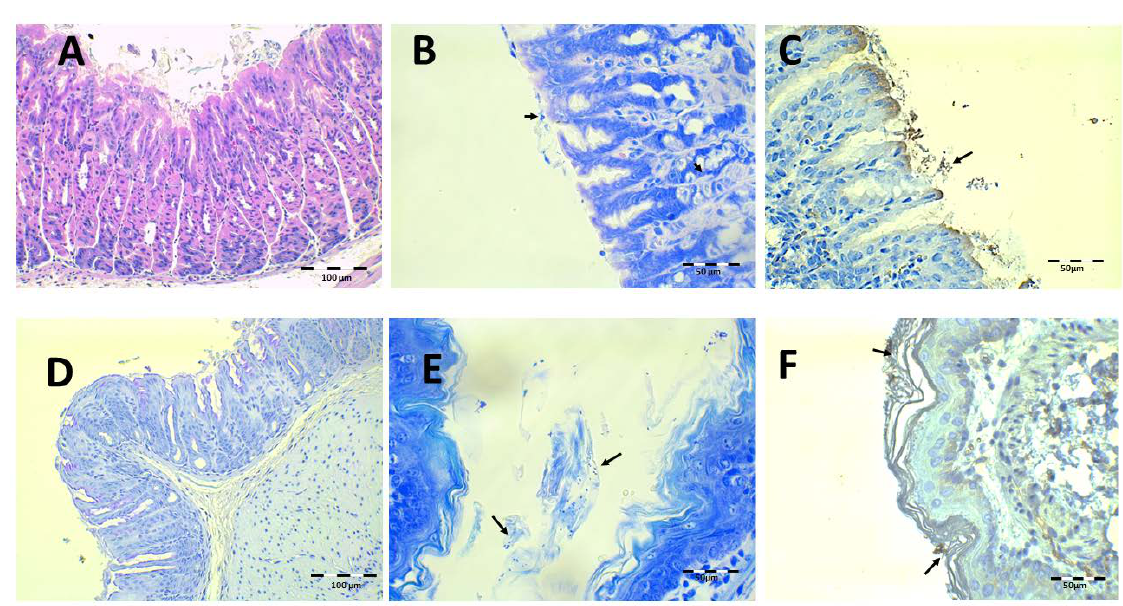
Figure 12. Infected animals treated with 89.4 mg/kg/day of Amox and 44.7 mg/kg/day of Clar in Mucolast ® micropho- tographs of the stomach ( A – D ) and esophagus ( E , F ), stained with H-E ( A ), Giemsa ( B , E , arrows indicate H. pylori bacteria), IHC ( C , F , arrows indicate H. pylori bacteria), and PAS ( D ).